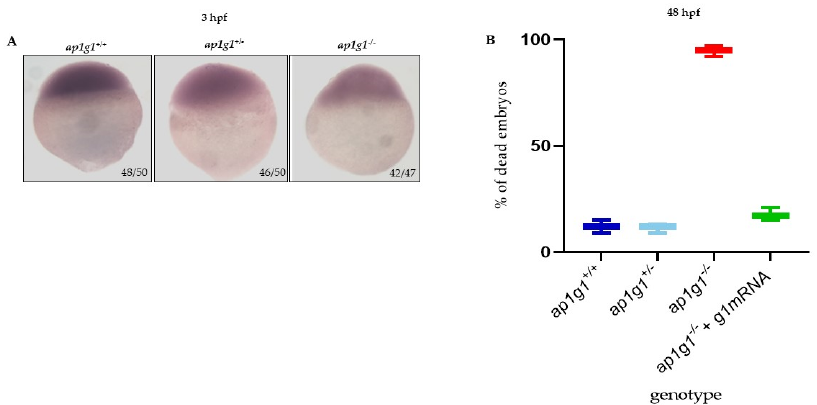
Figure 2. Characterization of ap1g1 mutant embryos. ( A ) Whole mount in situ hybridization (WISH) for dspb performed in embryos at 3.5 hpf. The experiment was done three times with n = 25 embryos at each experiment. Ratios at the bo tt om-right part of each picture specify the number of embryos showing the same staining pa tt ern, compared to the total number of embryos used for each experi- ment. The images were taken in dorsal position at 32× magni fi cation with a Zeiss Axiozoom V13 (Zeiss, Jena, Germany) microscope, equipped with a PlanNeoFluar Z1×/0.25 FWD 56 mm lens and Zen Pro software. ( B ) The graph in the panel shows, at 48 hpf, the percentage of dead embryos of the three di ff erent genotypes and the percentage of dead embryos after the microinjection with zebra fi sh wild type γ 1 mRNA. The experiment was repeated three times.